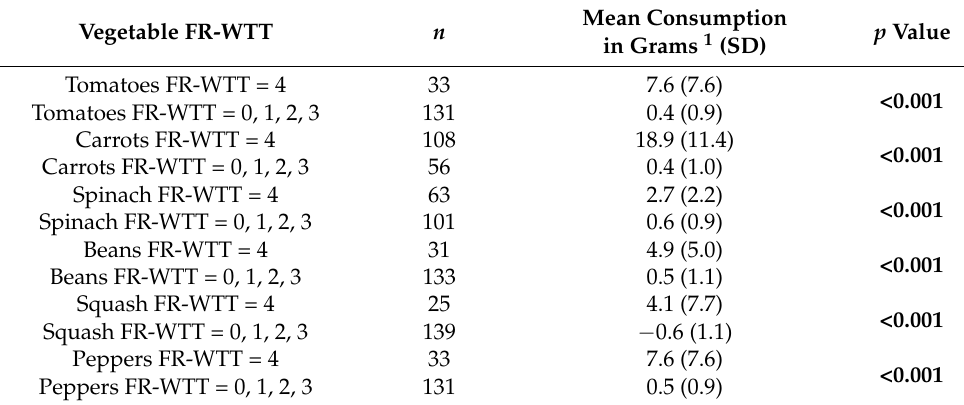
Table 2. Mean consumption of vegetables during observations by Farfan-Ramirez willingness-to-try (FR-WTT)